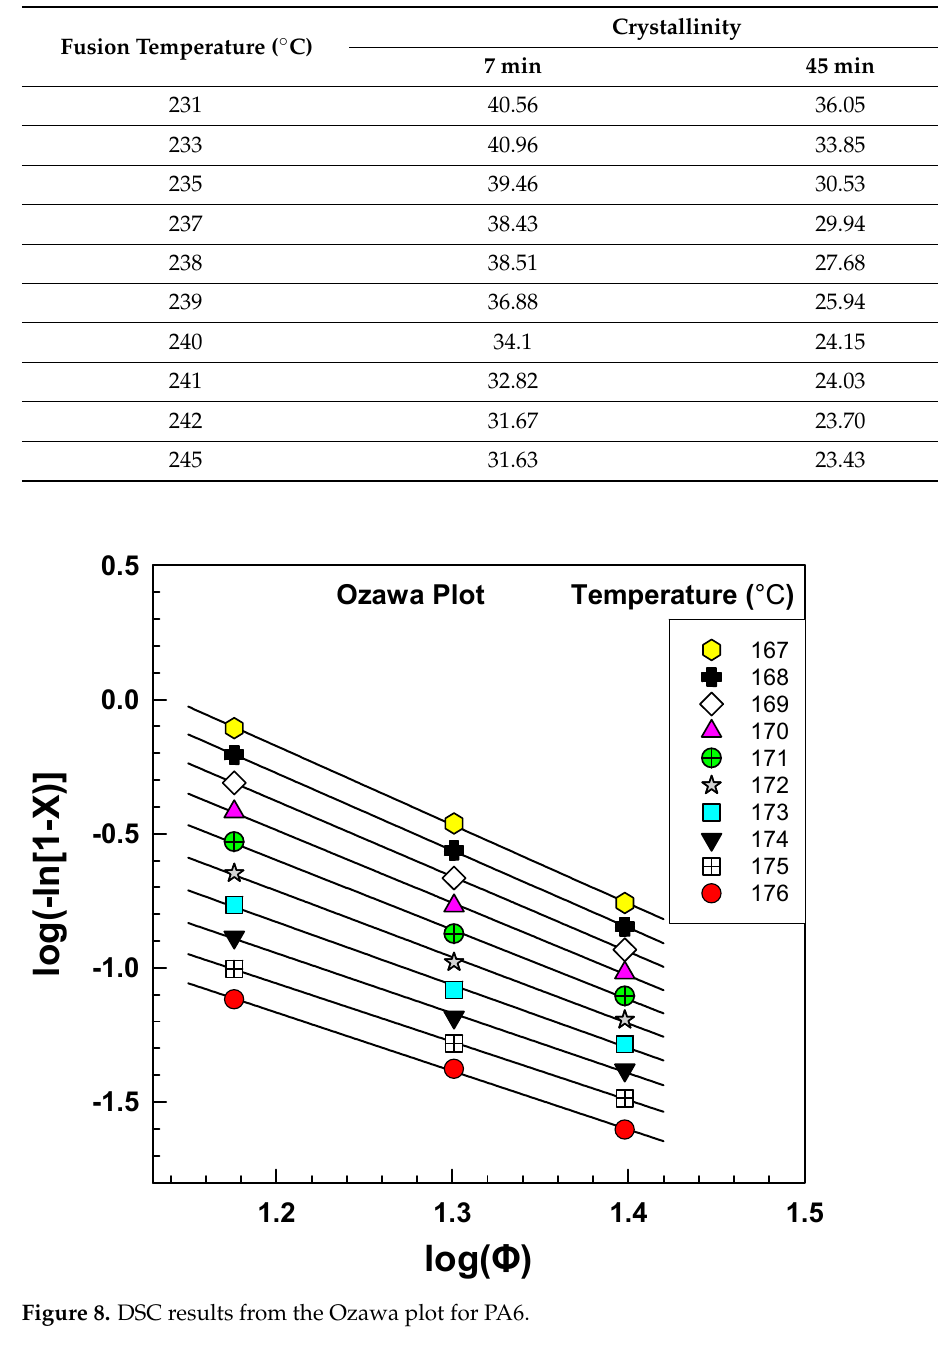
Table 4. Crystallinity of PA6 at different fusion times.